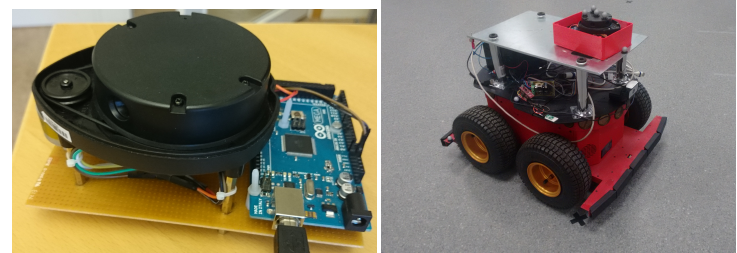
Figure 3. Photo of a mobile robot with a triangulation lidar mounted on its top. Figure 4. Photo of a mobile robot with a triangulation lidar mounted on its